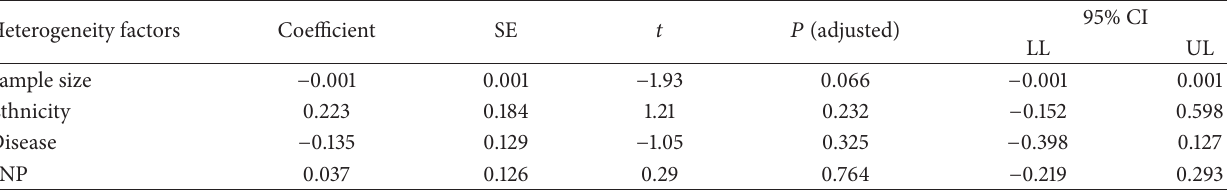
Table 4: Metaregression analyses of potential source of